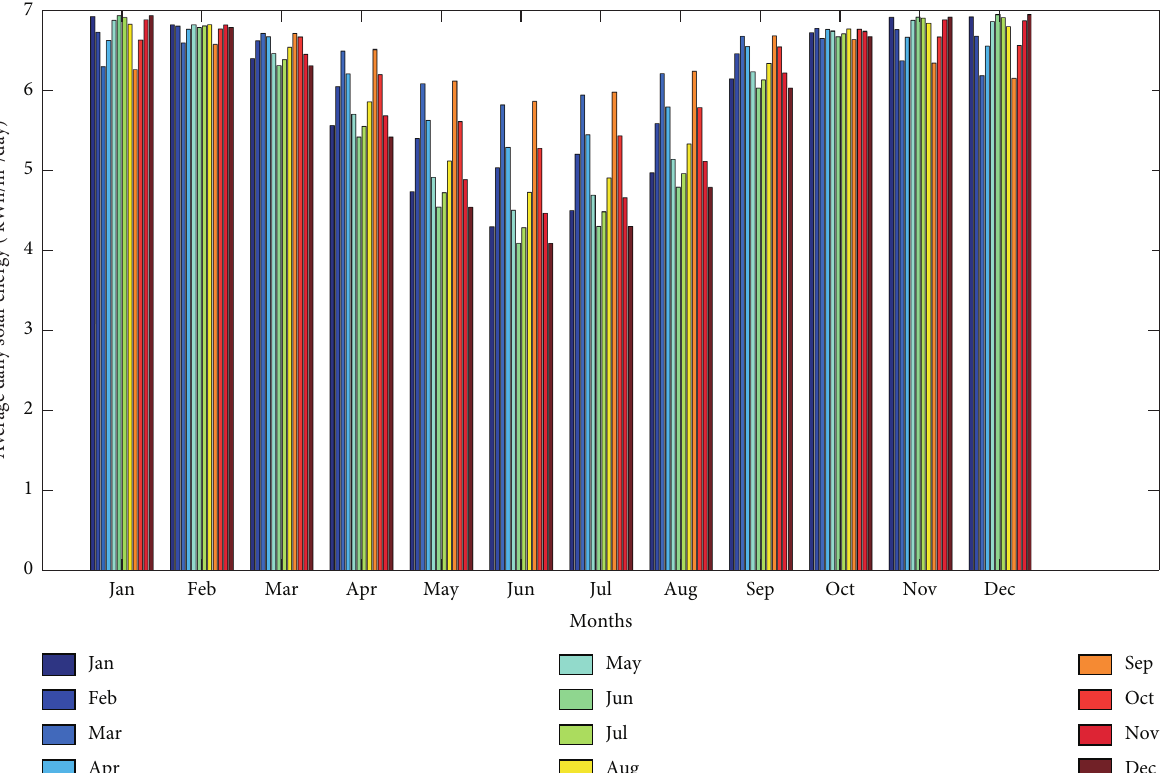
Figure 4: PV energy outputs at monthly optimized angles: July to December: (a) PV energy output at λ (c) PV energy output at λ Sep ; (d) PV energy output at λ Oct ; (e) PV energy output at λ Nov ; (f) PV energy output at λ Dec .